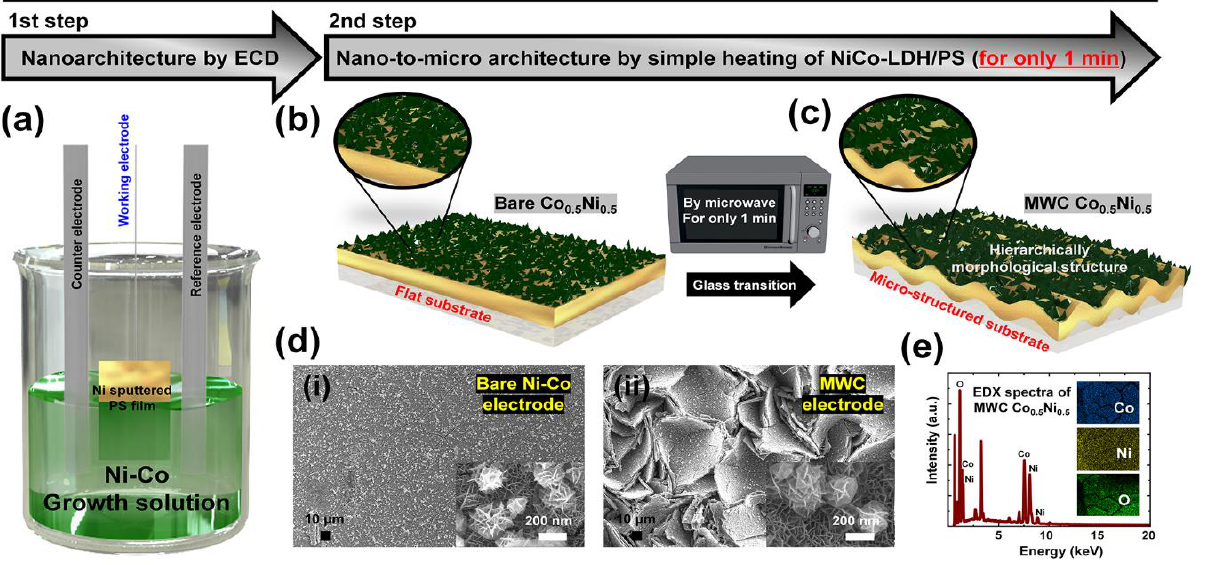
Figure 1. Schematic illustration of two-step synthesis of microwave-assisted crumpled Ni-Co com- posites (MWC) electrode with nano-to-micro structured hierarchical surface architecture ( a ) 1st step to assemble nano-architecture by electrochemical deposition (ECD) and ( b , c ) nano-to-micro architecture obtained by simple heating process of Ni-Co layered double hydroxides (LDHs)/PS electrode, with the assistance of microwaves for only 1 min. Material analyses including ( d ) SEM characterizations of surface morphology of bare and MWC electrodes and ( e ) EDX spectra and elemental mapping images of Co, Ni, and O in MWC Co0.5Ni0.5 electrode.